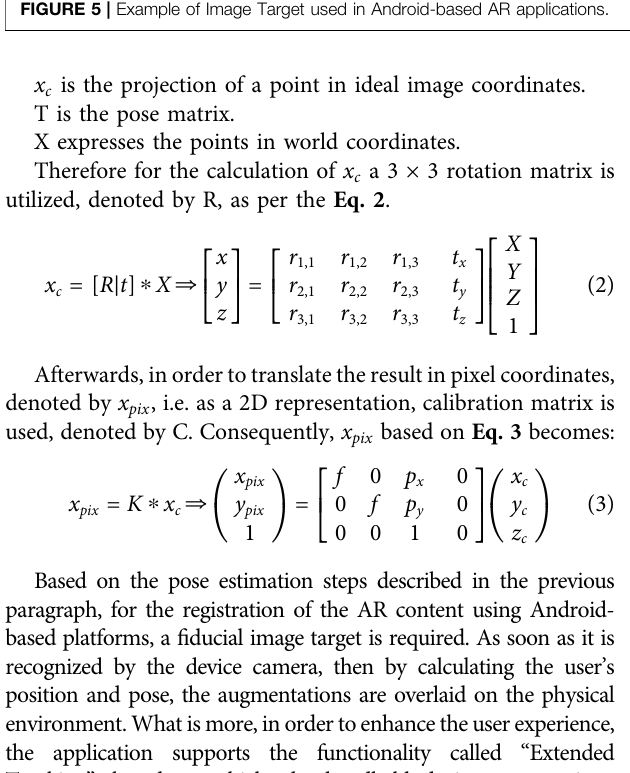
FIGURE 5 | Example of Image Target used in Android-based AR